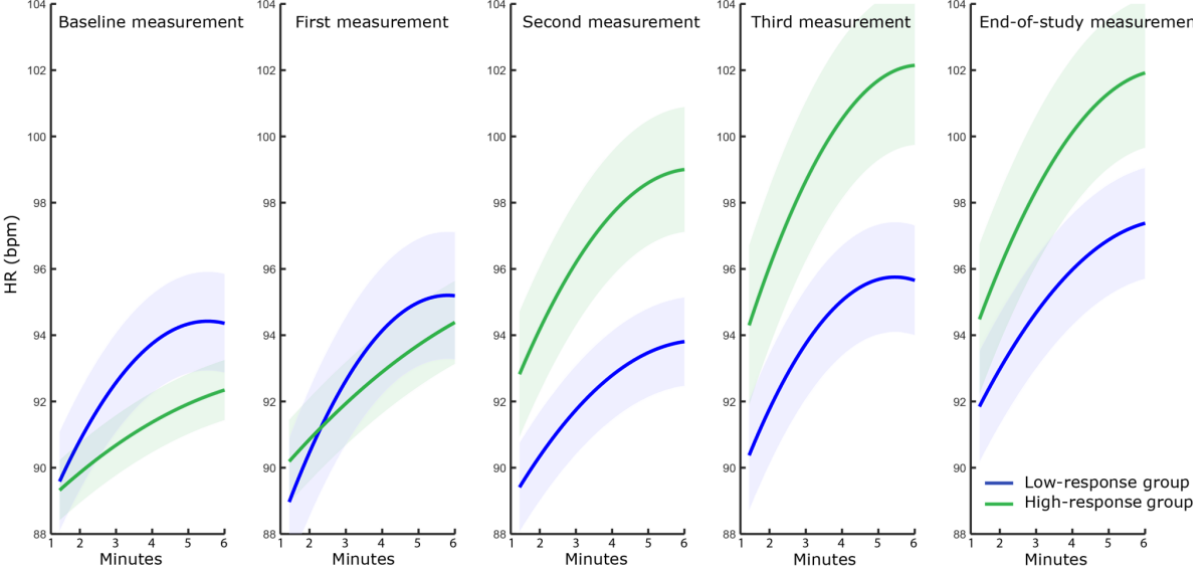
Figure 5. Mean quadratic polynomial fit to the changes in heart rate (HR) during all sessions while walking. The line represents the mean fit and the shadows represent the SD. bpm: beats per minute.